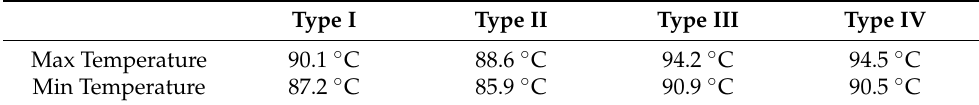
Table 2. A Comparison of High and Low Temperature